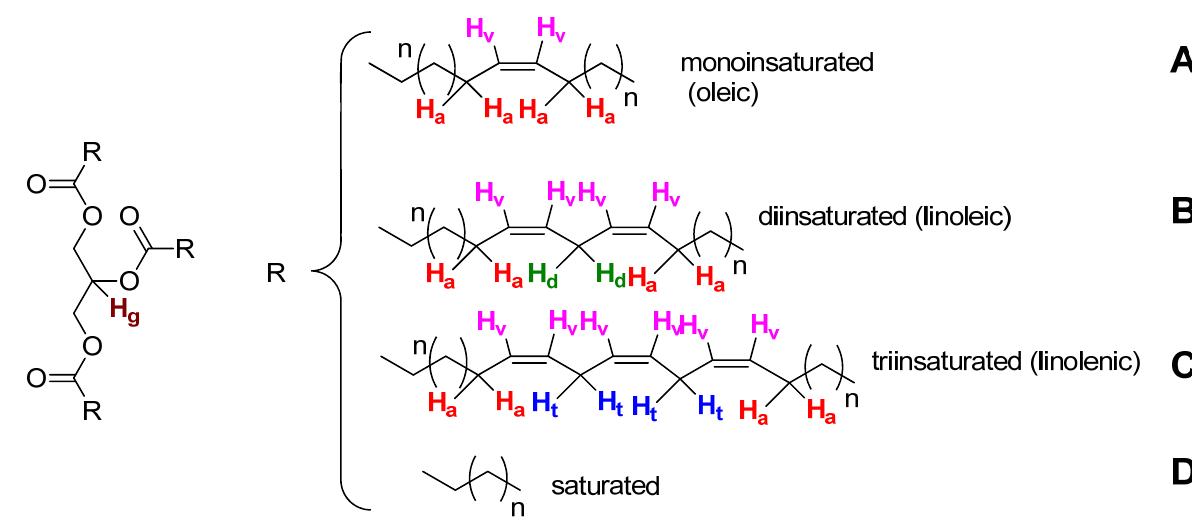
Figure 1. Chemical structure of the main triacylglycerols in